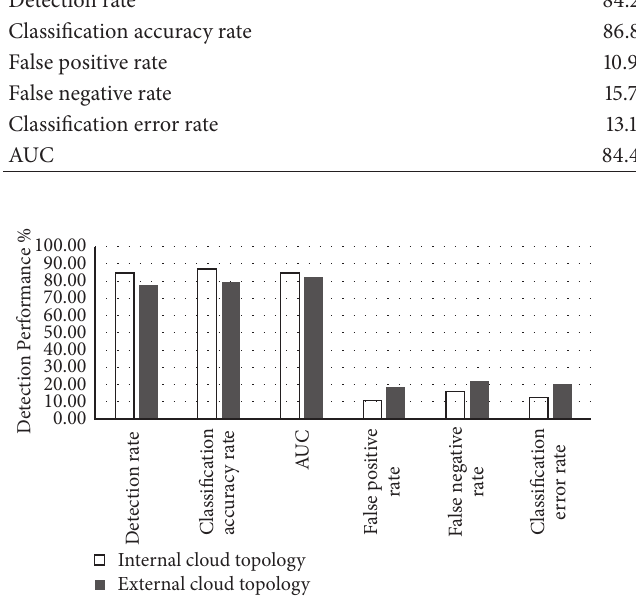
Figure 5: MADM performance results in cloud environment using 4D